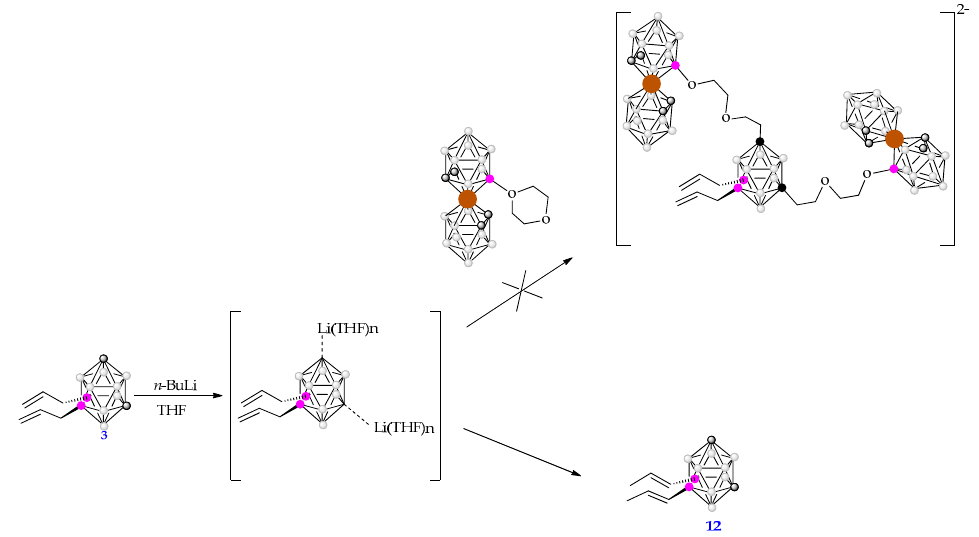
Scheme 4. Top: Designed a synthetic reaction to achieve the dianionic species. Bottom: Achieved reaction was the isomerization of 9,10-(CH 2 =CHCH 2 ) 2 -1,7- closo -C 2 B 10 H 10 , to 9,10-(CH 3 CH=CH) 2 -1,7- closo -C 2 B 10 H 10 . Dark circles are C c -H vertexes, pink circles are boron atoms, and grey circles are